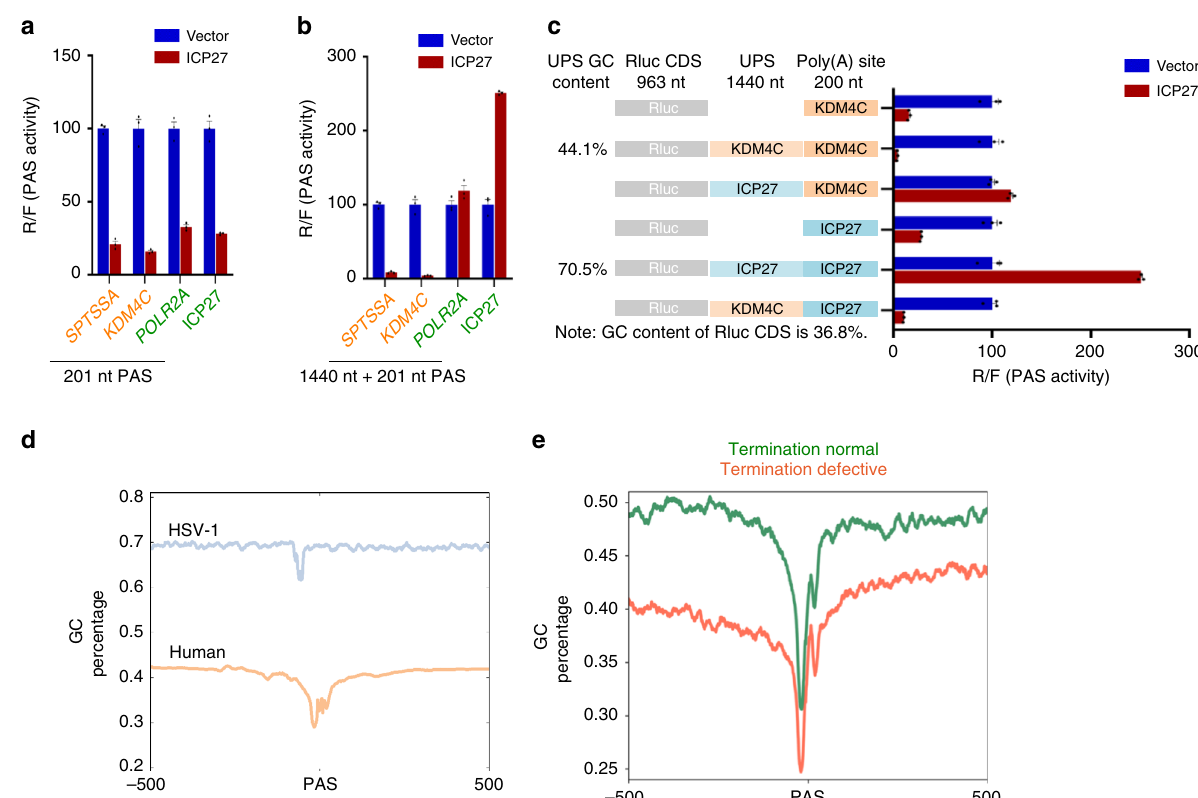
Fig. 5 ICP27 is a sequence-dependent activator of mRNA 3 ′ processing. The core sequences ( − 100 nt to + 100 nt ( a )) or the extended sequences (core plus 1440 nt upstream sequences ( b )) of four PASs, including SPTSSA and KDM4C (showed DoTT in HSV-1-infected cells) and POLR2A and ICP27 (no DoTT), were cloned into pPASPORT. These reporters were co-transfected with vector or an ICP27-expressing plasmid and mRNA 3 ′ processing activities (Rluc/Fluc) were plotted as mean ± s.d. c The core and extended PAS of KDM4 C and ICP27 as well the chimeric PASs between the two PASs were co-transfected with vector or an ICP27-expressing plasmid and the PAS activities (Rluc/Fluc) were plotted as mean ± s.d. The GC contents of the upstream sequences of both PASs are marked on the left. d The GC content at HSV-1 and human PASs. e The GC contents of PASs of host genes with signi fi cant DoTT (red) and without DoTT (green). Reporter assays in a , b , and c were performed at the same time under the same conditions and were displayed in multiple panels for